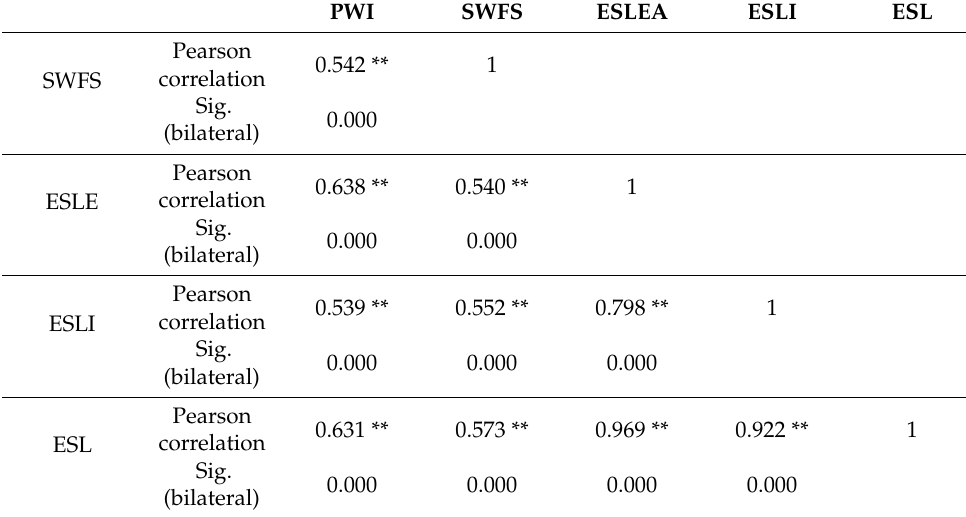
Table 6. Correlations between main